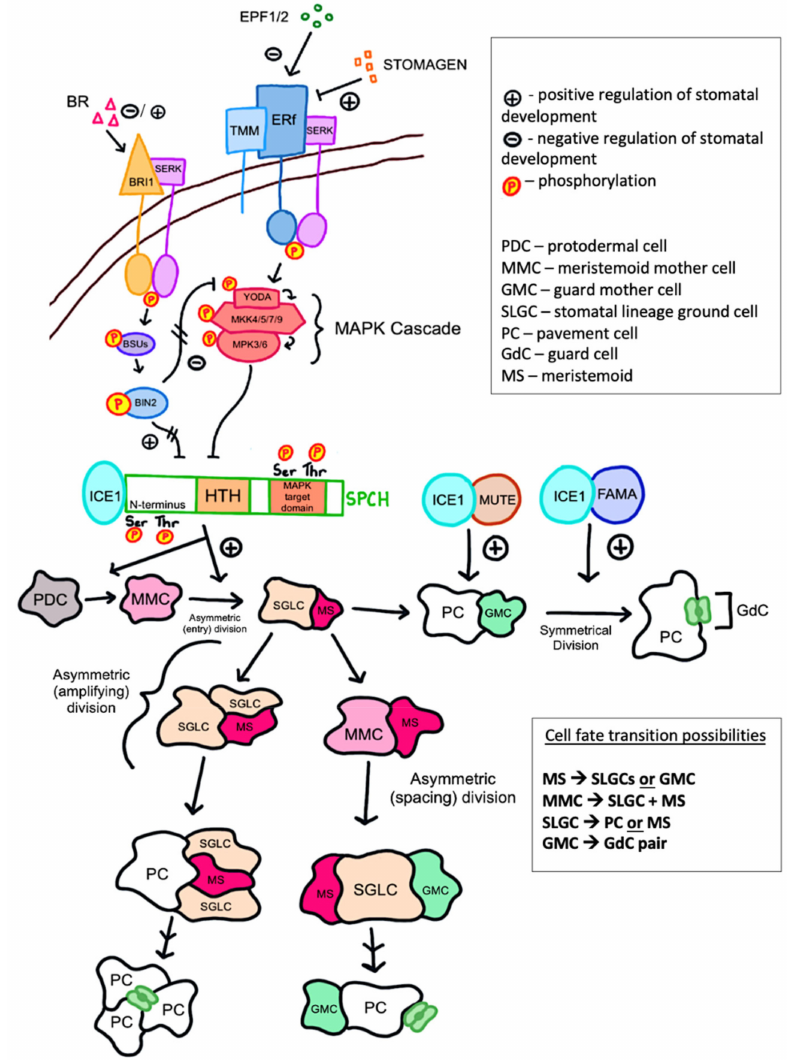
Figure 1. Pathway underlying stomatal development based on combined experimental data collected for the model plant Arabidopsis thaliana . In the peptide signalling pathway, negative regulators EPF1/2 compete with STOMAGEN for binding sites on TMM/ERf/SERK complexes to activate the MAPK cascade and inhibit activity of SPCH downstream by MPK3/6-mediated phosphorylation of serine and threonine residues in the N-terminus and MAPK target domain of the SPCH tran- scription factor. Through action of brassinosteroids (BR) on BRASSINOSTEROID INSENSITIVE 1 (BRI1)/SERK receptor complexes, both positive and negative regulation of stomatal development can occur. By BR negative regulation, the activity of BIN2 can be suppressed, preventing YODA phosphorylation (leading to the continued inhibition of SPCH activity). By BR positive regulation, BIN2 suppression prevents phosphorylation of SPCH, hence maintaining its activity. Active SPCH stimulates the progression of PDCs into MMCs, and MMC transformation into SLGCs and meriste- moids by asymmetric (entry) division. MUTE activity modulates GMC formation and FAMA activity modulates symmetric divisions as GMCs transition into mature guard cells. ICE1/2 associates with SPCH, MUTE and FAMA to ensure appropriate functionality of the bHTH transcription factors in the regulation of cell fate transitions. Additionally included are the cell fate transition possibilities for the various cells of the stomatal lineage. MKK4/5/7/9 and MPK3/6 refer to various mitogen- activated protein kinases. HTH refers to the helix-turn-helix motif of the SPCH transcription factor. BSUs refer to BRI1 suppressors in the BR regulated pathway (acting upstream of